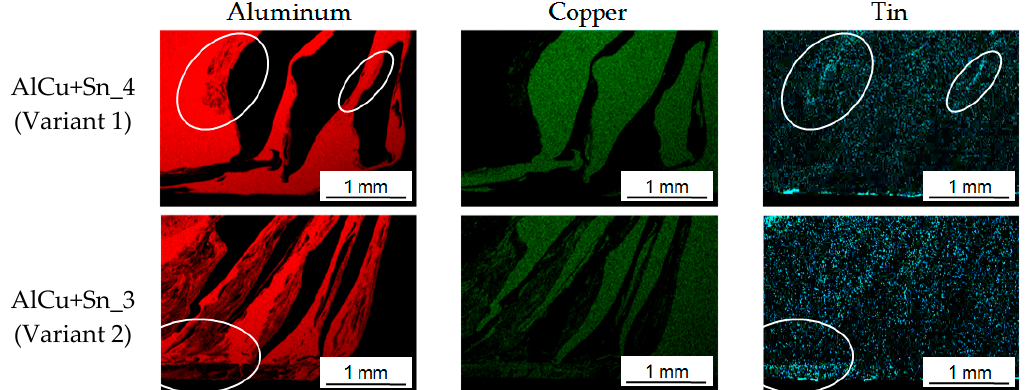
Figure 6. EDX element mapping: Upper row AlCu+Sn_4 (variant 1) and lower row AlCu+Sn_3 (variant 2) .